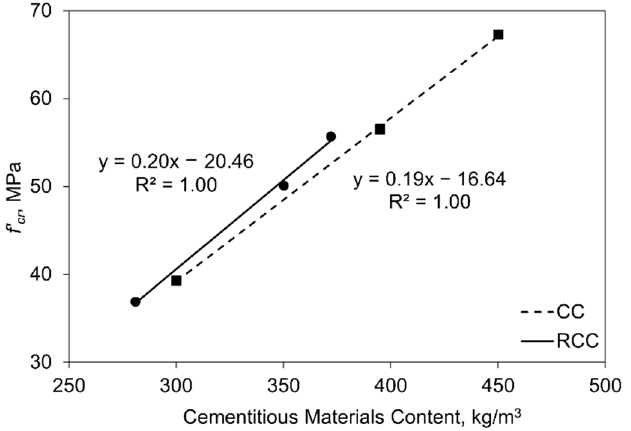
Figure 5. Cementitious content and required compressive